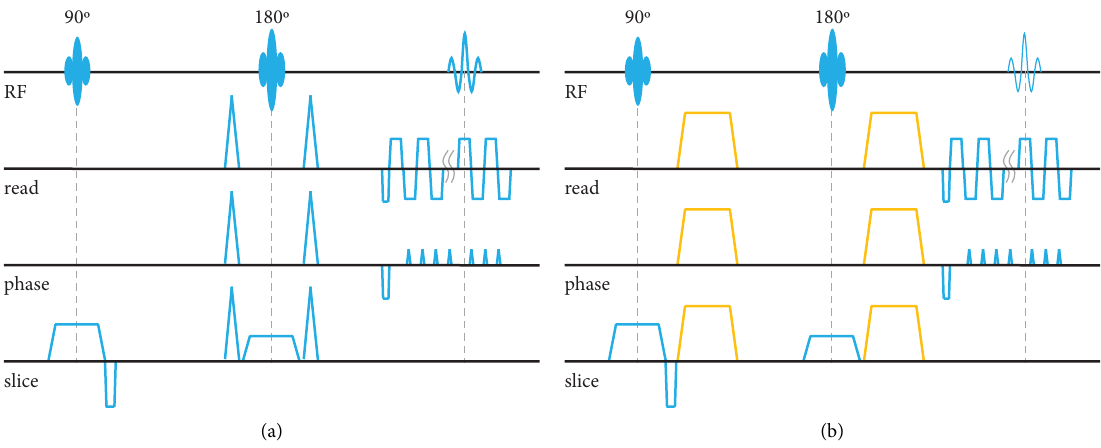
Figure 5: An optimized SE-EPI sequence at nominal b � 0 (a) and nominal b ≠ 0 (b).